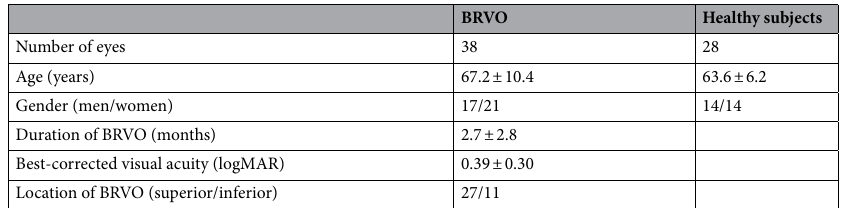
Table 1. Clinical characteristics of patients with branch retinal vein occlusion and health subjects. Values are presented as the mean ± standard deviation. logMAR logarithm of the minimum angle of resolution, BRVO branch retinal vein occlusion.